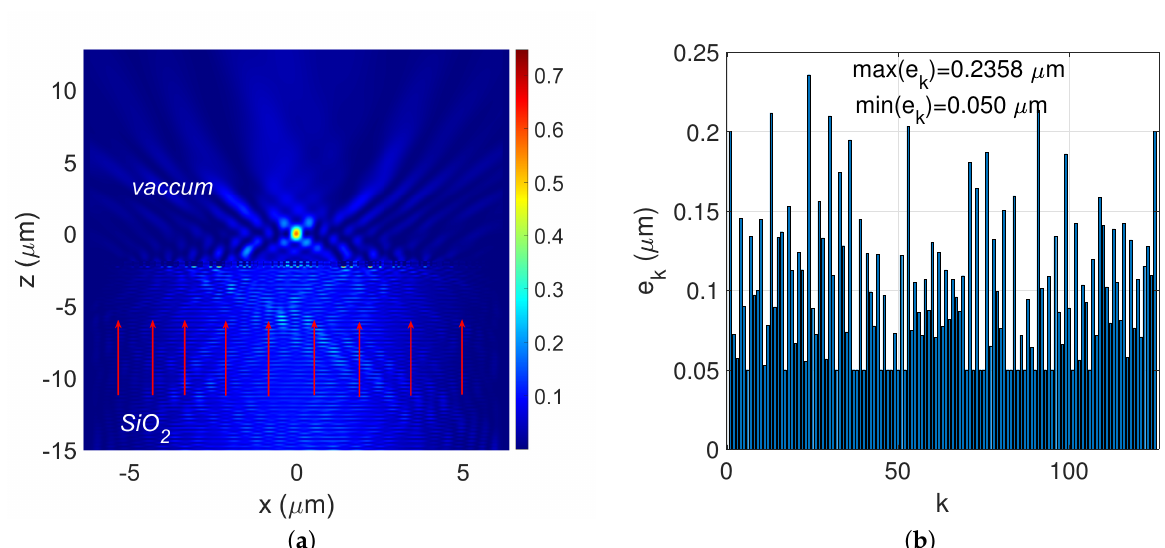
Figure 11. Design of a plasmonic gold-flat-metalens of d = 12.75 µ m-wide consisting of N p = 125 gold-nanoridges and air-gap focusing a normal incident TM-polarized plane wave at a wavelength λ = 0.637 µ m at a distance of 3 λ . ( a ) presents the cartography of the normalized magnetic field intensity in the plane ( X , O , Z ) . ( b ) shows the values of the (ridges, air-gaps)-widths sequence [ e k ] k with respect to their locations labelled by k . Numerical parameters: λ = 0.637 µ m, N p = 125, e z = 400 nm, TM polarization. ( a ) | H y ( x ,0 ) | 2 /